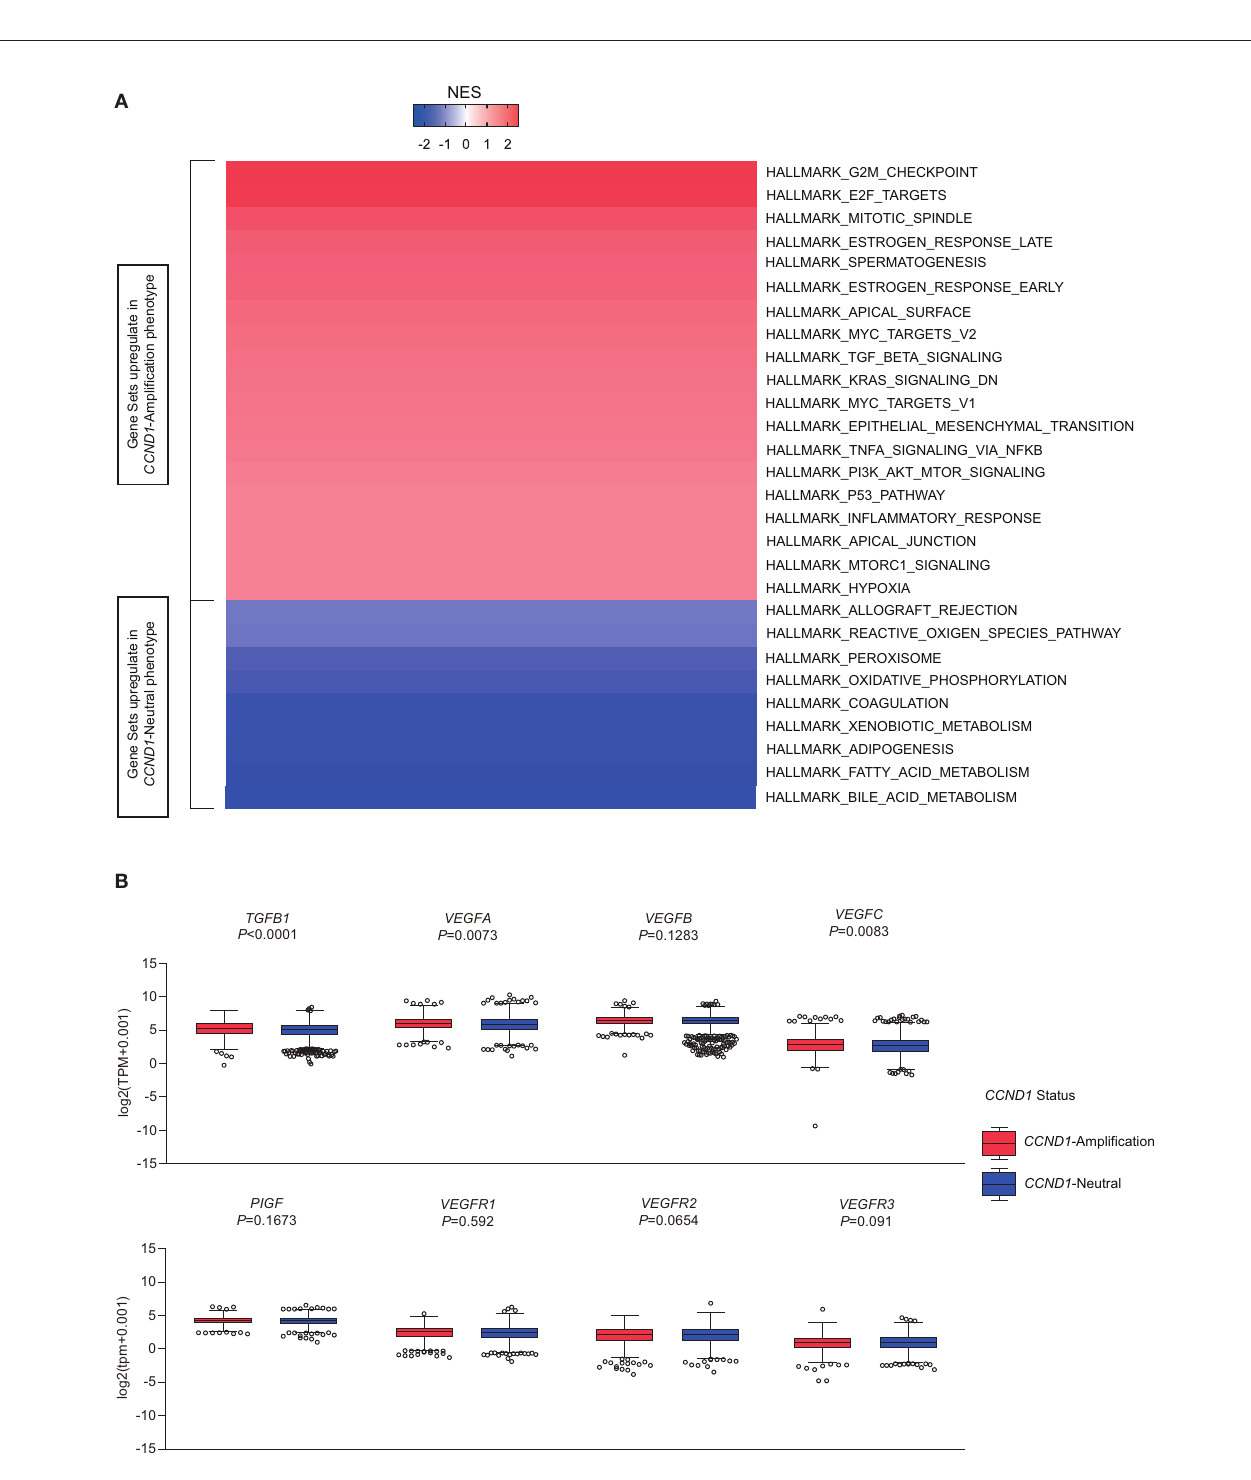
FIGURE 4 | Identification of hallmarks associated with cyclin D1 (CCND1) amplification in The Cancer Genome Atlas (TCGA) pan-cancer cohort ( n = 2,633). (A) Different upregulation of inflammatory pathways among the CCND1 amplification group and the CCND1 neutral group in the TCGA pan-cancer cohort. The result is expressed according to the normalized enrichment score (NES). (B) The box and whiskers plots depict differences in transcript-level changes of transforming growth factor (TGF)B1 , vascular endothelial growth factor (VEGF)A–C , placental growth factor (PIGF) , and VEGF receptor (VEGFR)1–3 between the CCND1 amplification group and the neutral group in the TCGA pan-cancer cohort. Within each group, the scattered dots represent gene values, and the thick line represents the median value. The bottom and top of the boxes are the 25th and 75th percentiles. Differences between the two groups were determined by unpaired t -tests.